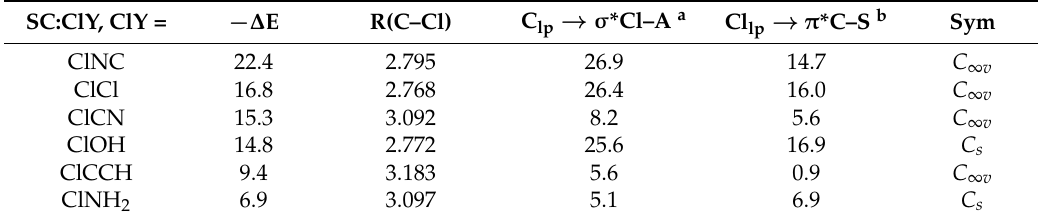
Table 2. Binding energies ( − ∆ E) and charge-transfer energies (C lp → σ *Cl–A and Cl lp → π *C–S,